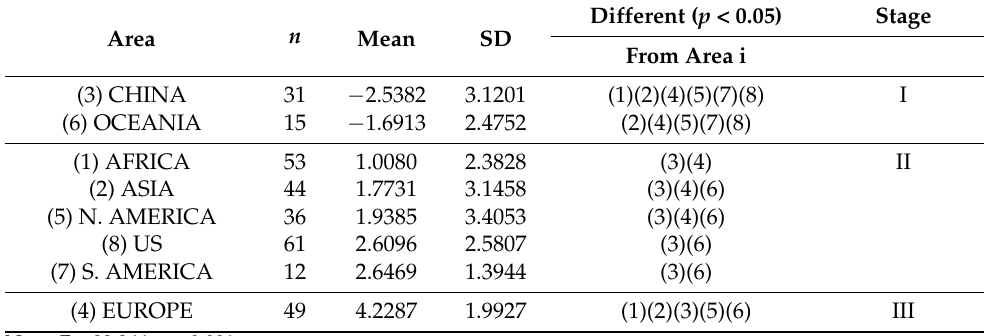
Table 1. Comparison of location parameters in continents and countries as of 19 October 2020.